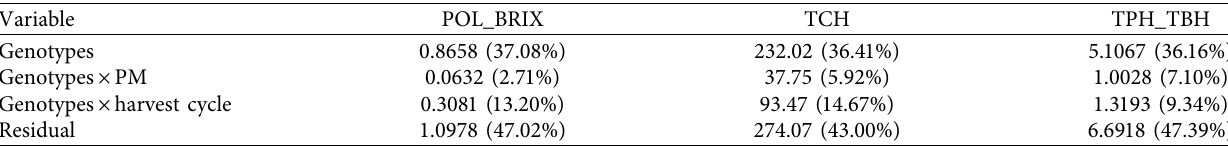
Table 4: Components and percentage of variance as obtained in a pooled joint analysis with a mixed REML/BLUP model, considering genotype, genotype × planting material, genotype × harvest cycle, and residual as random effects.